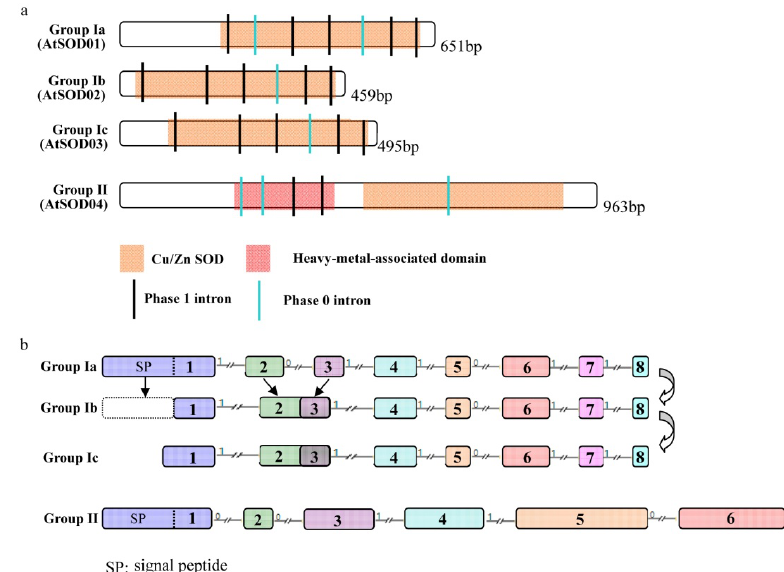
Figure 4. Structure and sequence features of conserved Cu/Zn SOD genes. ( a ) Gene structure and protein motif. The structure of an Arabidopsis thaliana gene (indicated on the left) is shown as an example for each subgroup (in parenthesis on the left). Protein motifs are shown as colored boxes, whereas introns of different phases are shown as colored vertical lines. ( b ) Detailed analyses of gene structure of Cu/Zn SOD genes. The numbers indicate different exons. The introns are drawn to scale. The arrows represent stepwise duplication of Cu/Zn SOD genes from group I during plant